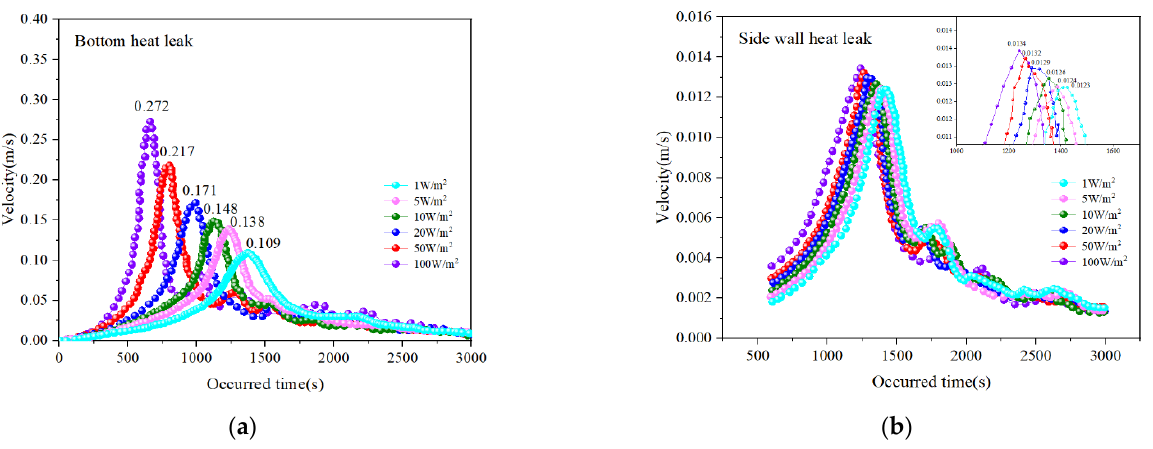
Figure 2. Effect of heat leak at the bottom ( a ) and the side wall ( b ) on vertical velocity of interface monitoring points on the rollover process. This figure is adapted from [31] .